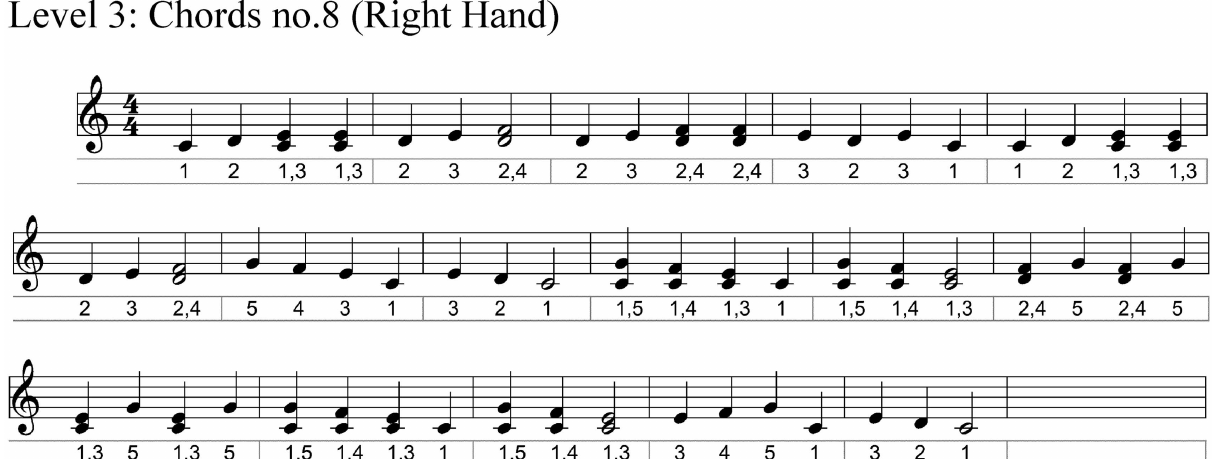
FIGURE 1 | Excerpts of musical scores of three pieces, one at each level, with digit number under each note .